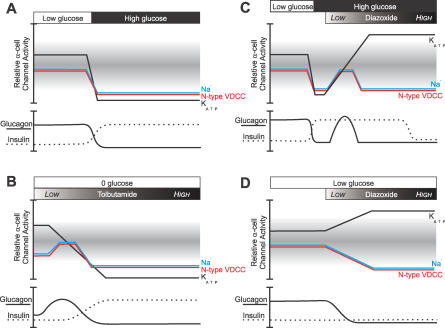
A Model for the Suppression of Glucagon Secretion by an Intrinsic α-Cell PathwaySchematic representation of the effects of glucose, tolbutamide, and diazoxide on α-cell KATP, Na+, and N-type Ca2+ (VDCC) channel activities and glucagon secretion is shown. The insulin response is also shown for comparison with our experimental results (dashed lines, lower panels). The grey gradient represents a “window” of α-cell KATP channel activity that supports the activation of Ca2+ and Na+ channels. Above this window, the cell is hyperpolarized and Ca2+ and Na+ channel activation is prevented, whereas KATP channel activity below this window depolarizes the cell and causes voltage-dependent inactivation of Ca2+ and Na+ channels.(A) High-glucose concentration reduces α-cell KATP channel activity, reducing glucagon secretion.(B) Graded application of tolbutamide (in zero glucose) transiently increases glucagon secretion as KATP channel activity is reduced through, and eventually below, the window supporting glucagon release.(C) The graded application of diazoxide in high-glucose conditions increases α-cell KATP channel activity into, and then above the window supporting glucagon secretion. The result is a transient “re-activation” of glucagon secretion at low-diazoxide concentrations.(D) In low-glucose (1–2 mM) conditions, graded application of diazoxide increases KATP channel activity above the window supporting glucagon secretion, causing a monotonic inhibition of glucagon release.